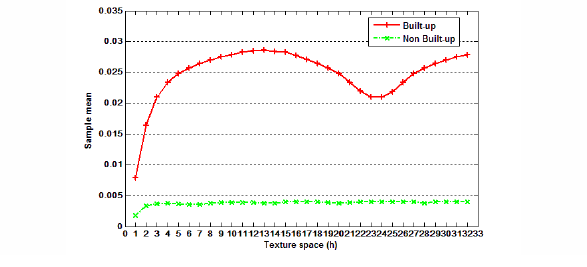
Figure 5 Relationship between sample mean and h